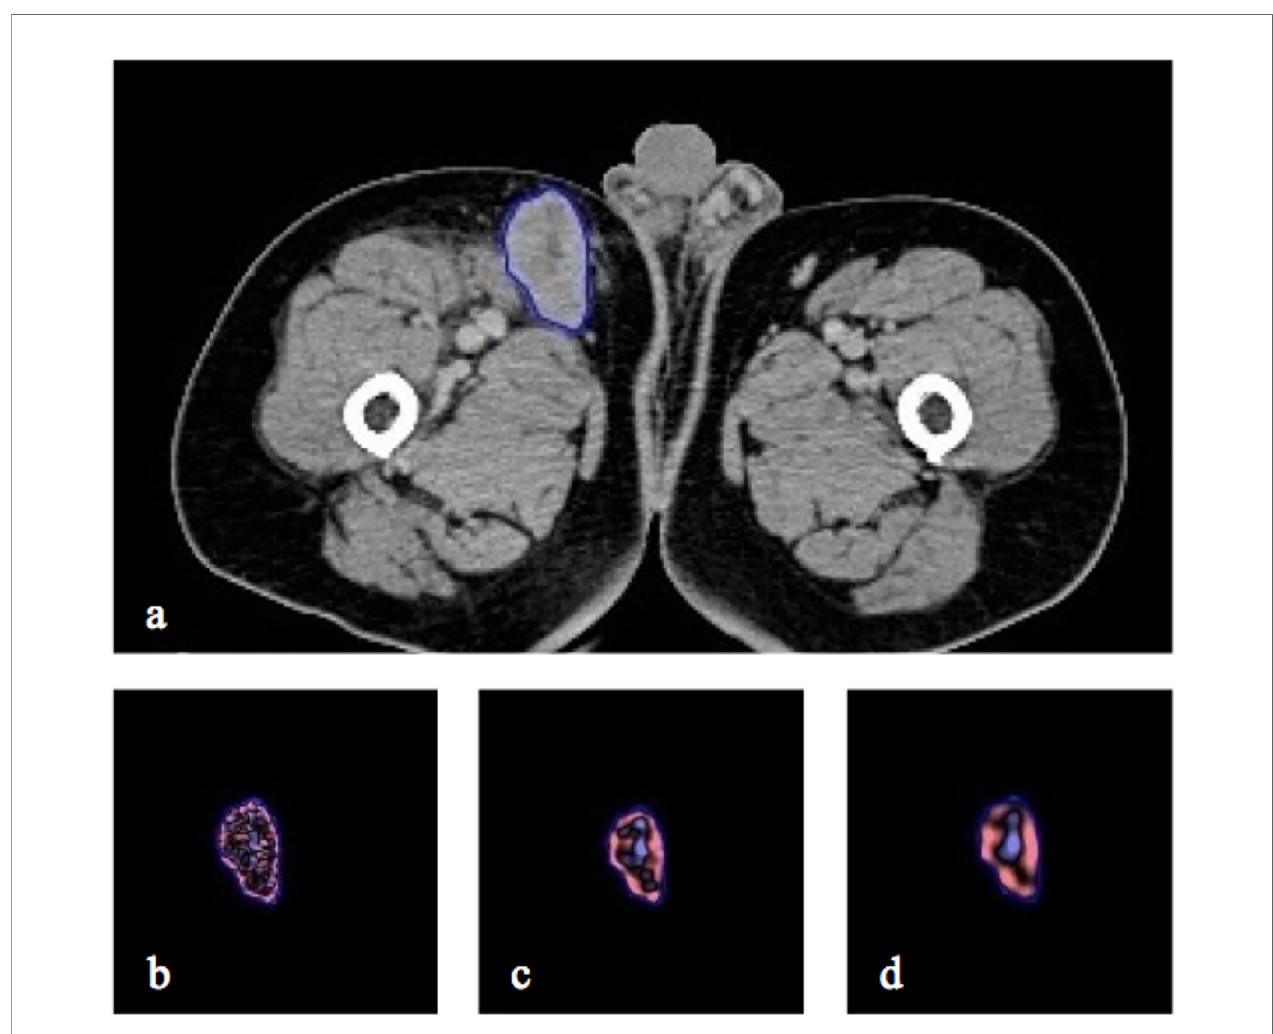
FIGURE 2 | CT axial image with right inguinal lymph node segmented in 2D (A) and the resulting. Illustration of different image fi ltration as part of CTTA at (B) fi ne (SSF = 2mm), (C) medium (SSF = 4mm) and (D) coarse (SSF = 6mm) texture